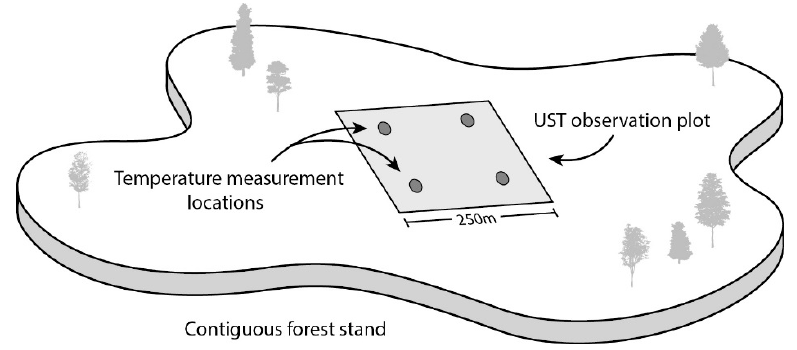
Figure 2. Understory temperature ( T ust ) observation plot and sensor locations.